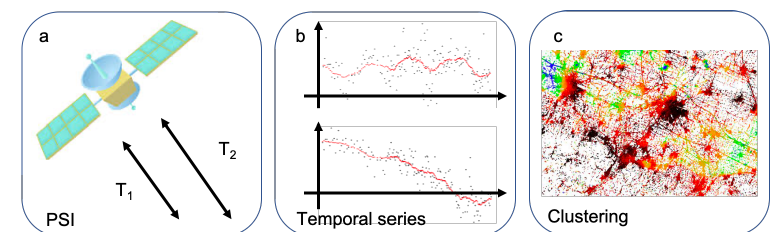
Figure 1. The study consists of three distinct steps: from PSI ( a ) analysis we were able to determine the temporal series of terrain deformations ( b ), which were finally clusterized ( c ) to outline the presence of similar patterns.